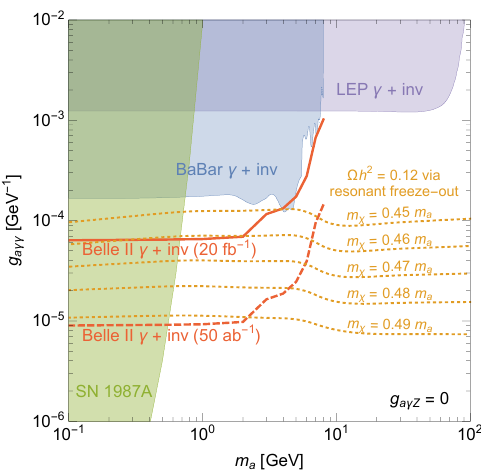
Figure 4 . Present and future constraints on ALPs decaying into DM compared to the parameter region where one can reproduce the observed DM relic abundance via resonant annihilation of DM into photons. Note that this process is e(cid:14)cient only if m (cid:31) is slightly smaller than m a = 2 (see (cid:12)gure